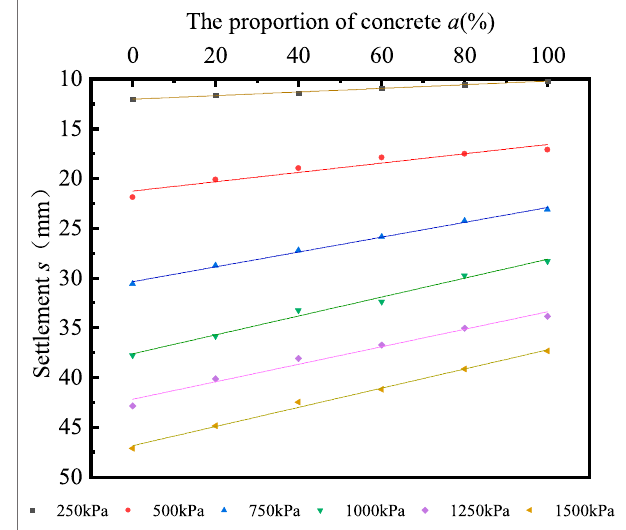
FIGURE 4 | Dry-wet cycles vs crushing rate.